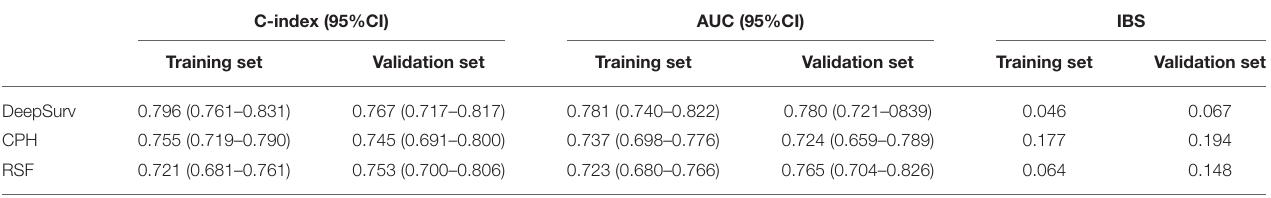
TABLE 3 | Performance of different models.